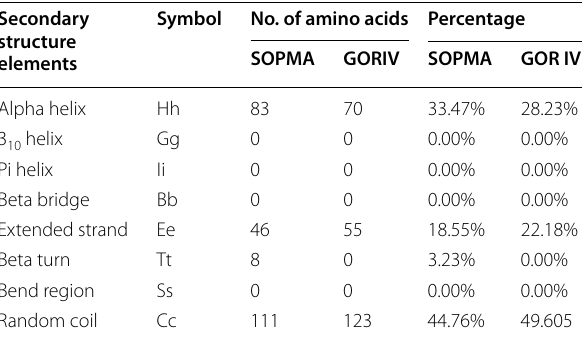
Table 5 Secondary structure elements developed by SOPMA and GRO4